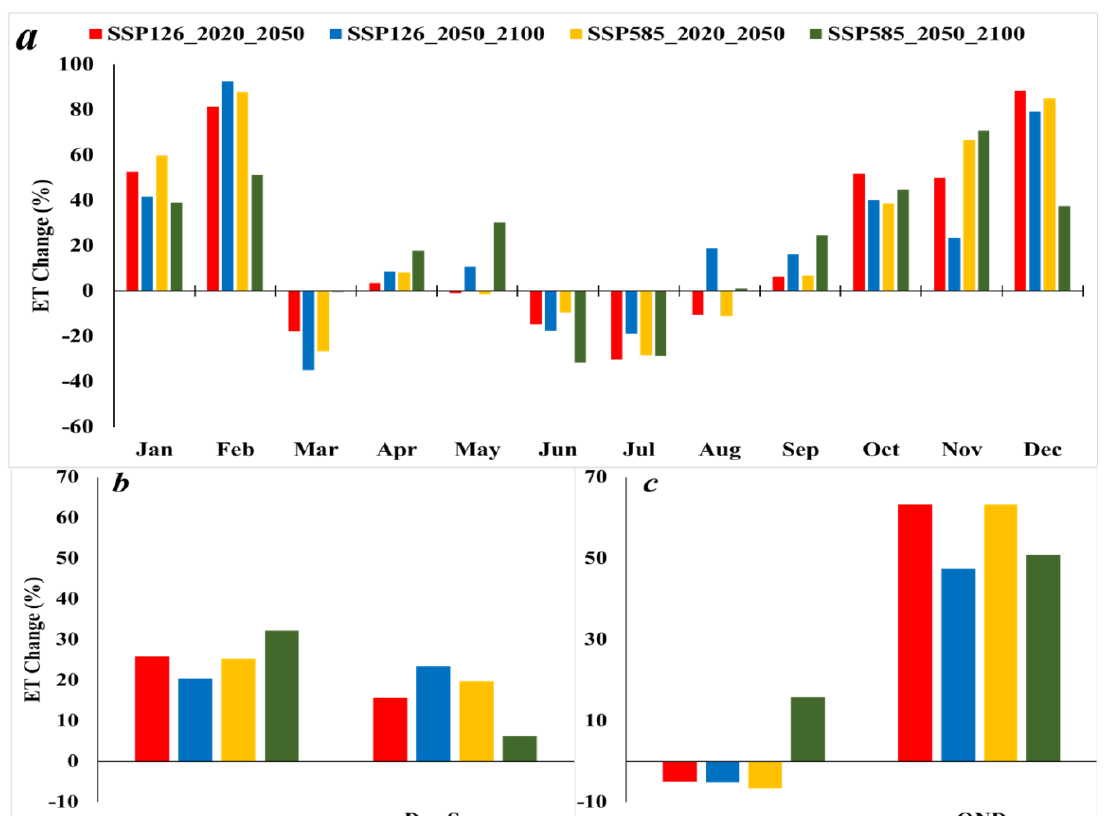
Figure 6. Relative evapotranspiration changes: ( a ) monthly, ( b ) seasonal, and ( c ) in rainy seasons.